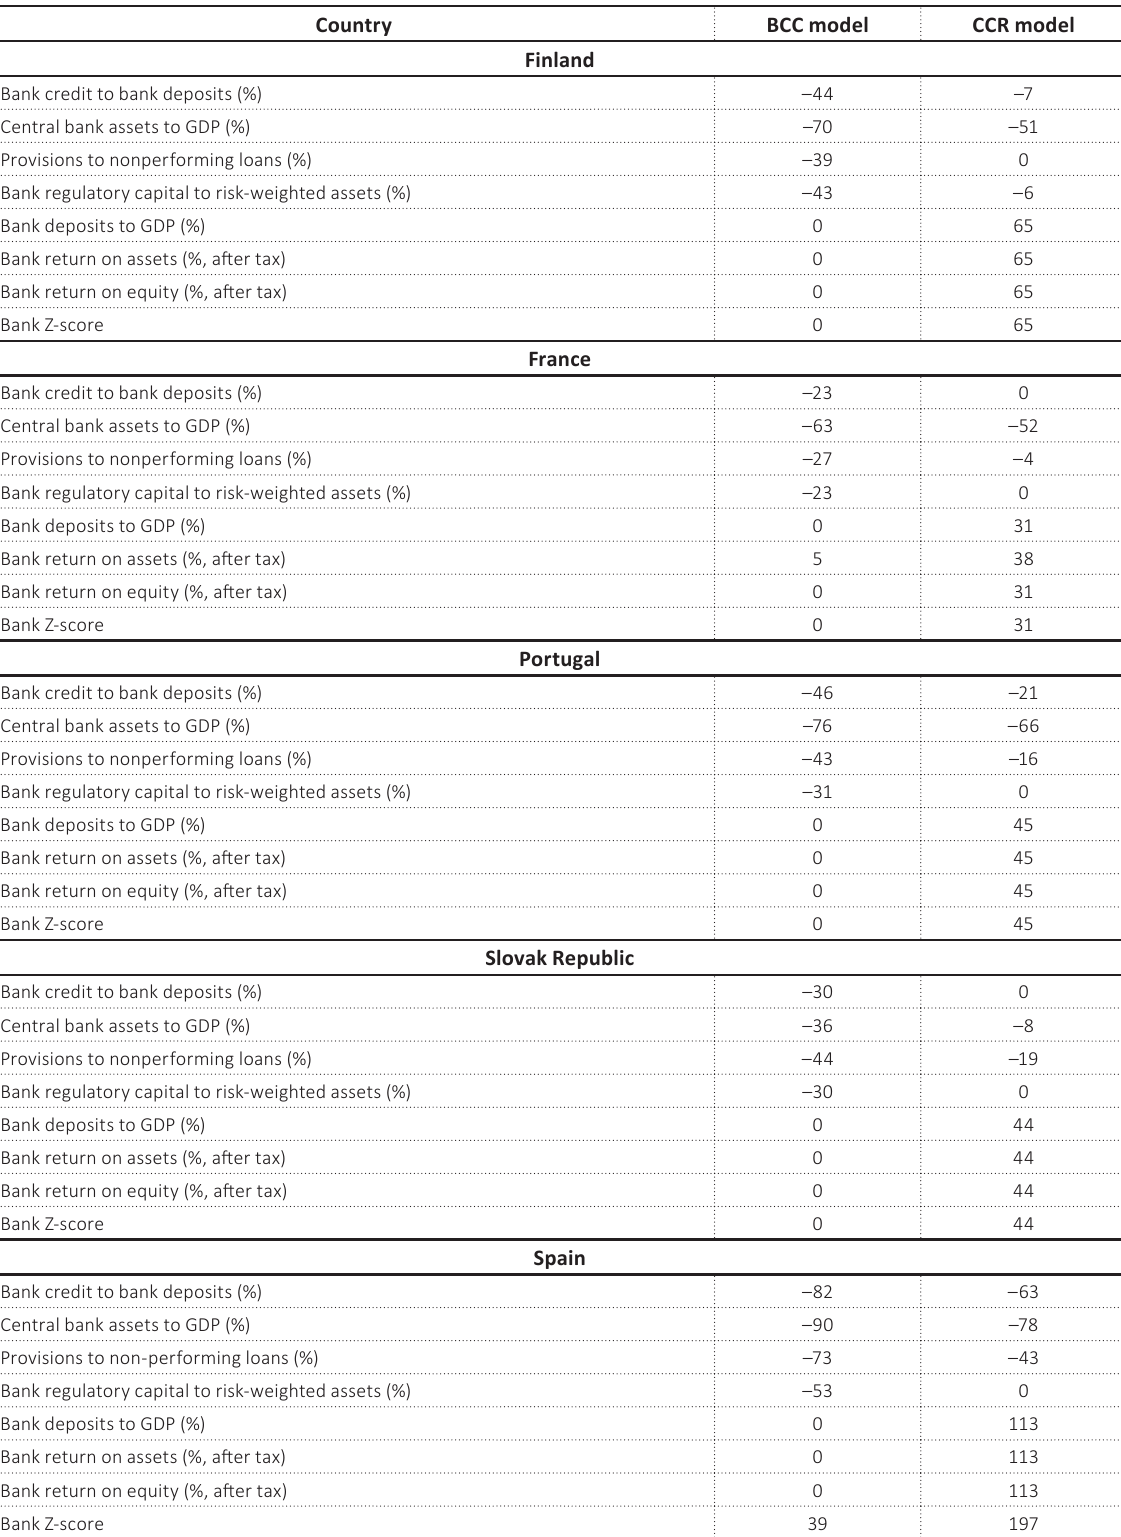
Table D1. Efficiency upside potential of banks for some European countries, calculated based on the BCC model and the CCR model of DEA Country BCC model CCR